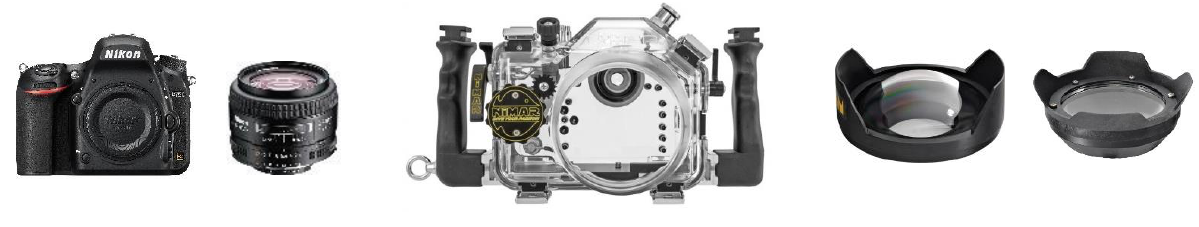
Figure 4. Nikon D750 camera, Nikkor AF 24 mm f/2.8D, NiMAR NI3D750ZM pressure housing and different ports used (from left to right).